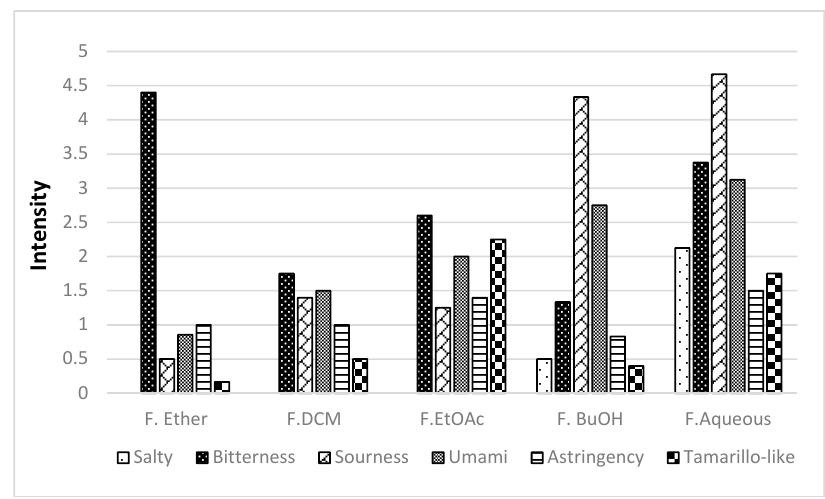
Figure 4. Taste intensity profile of the five yellow tamarillo fractions .